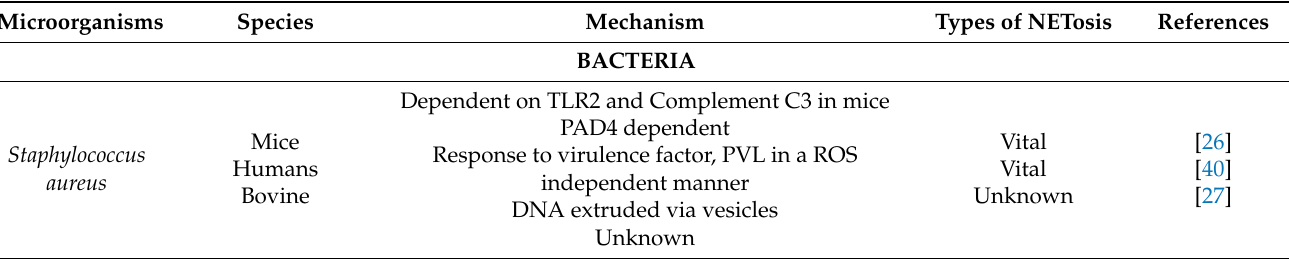
Table 1. Summary of mechanisms of neutrophil extracellular trap formation in different